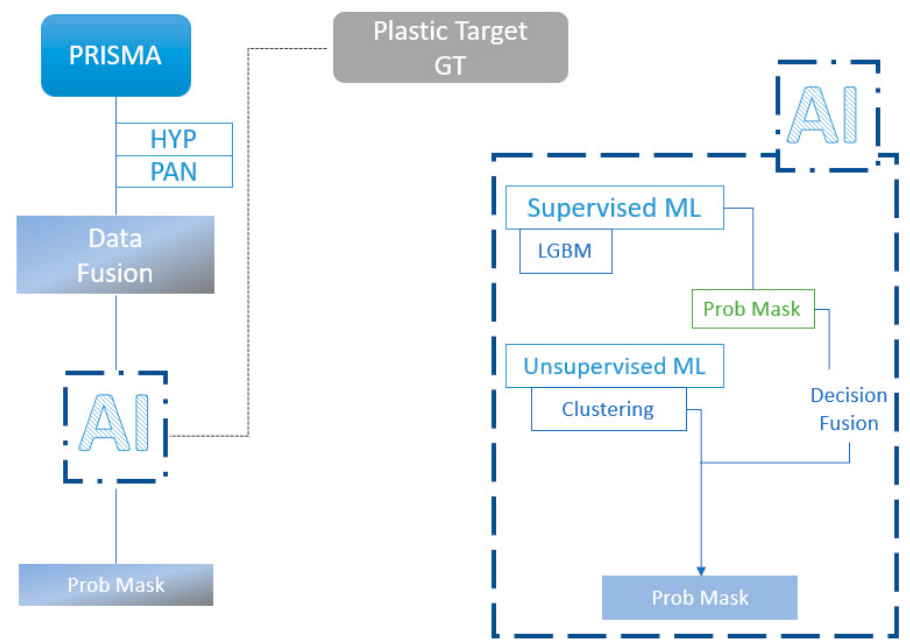
Figure 6. Workflow of the proposed combination of ML algorithms for marine plastic litter detection exploiting hyperspectral PRISMA data.